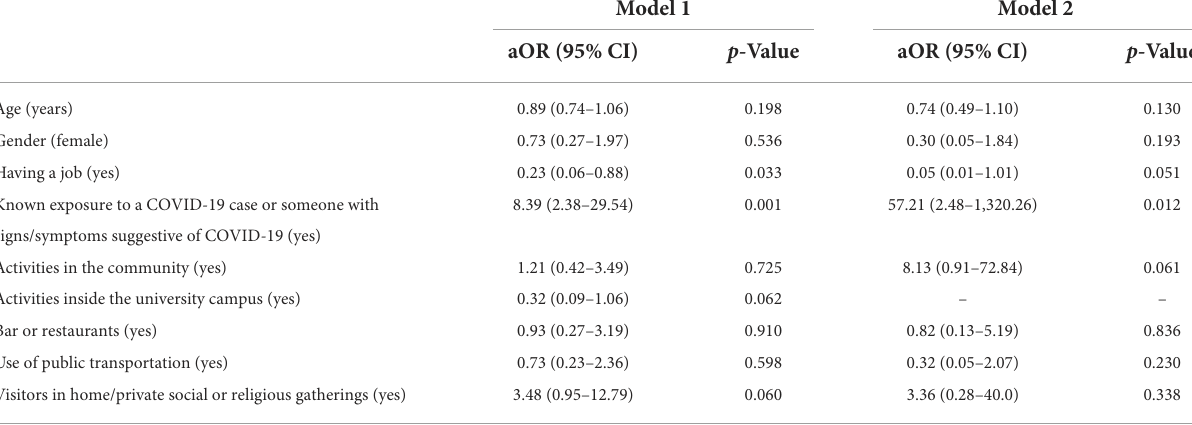
TABLE 4 Multivariable conditional logistic regression model for SARS-CoV-2 infection among Sapienza University students (Model 1) or restricted to those students that did not report attending the university campus in the 2 weeks before testing (Model